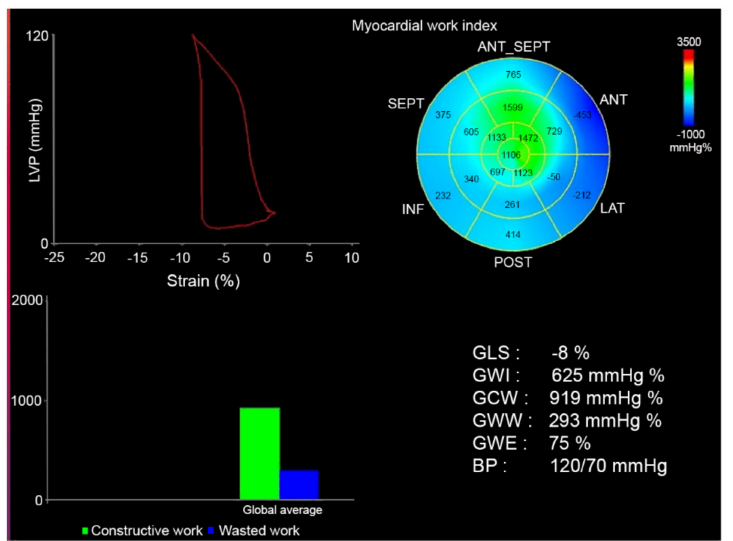
Figure 1. Myocardial work analysis in a patient with transthyretin cardiac amyloidosis (ATTR-CA). Green color in the Bull’s eye and graph lower left represents well preserved myocardial work (apical section) and blue color wasted work (base and mid ventricular segment, this in accordance with apical sparing pattern. The Y-axis in the lower left represents global constructive (GCW) and wasted work (GWW)